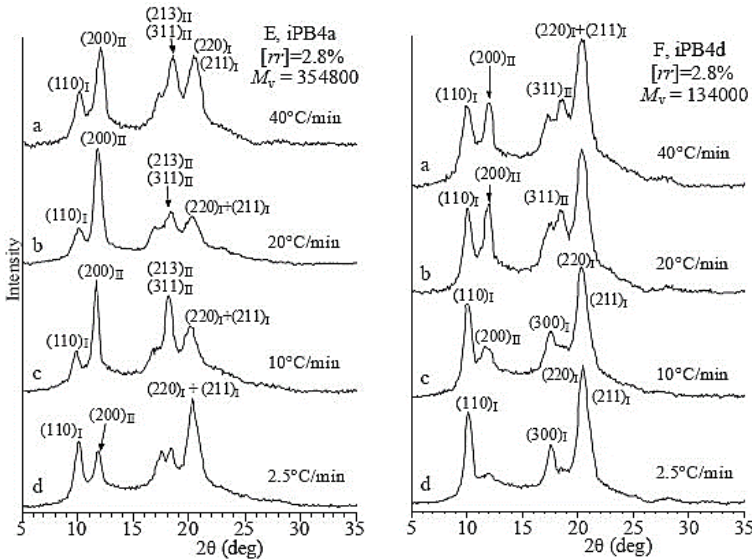
Figure 12. X-ray powder diffraction profiles of samples of iPBu of same stereoregularity but different molecular weight crystallized from the melt by cooling the melt to room temperature (or lower temperature) at the indicated cooling rates. The (110) I , (300) I and (220) I /(211) I reflections of form I at 2θ = 9.9°, 17.3° and 20.5°, and the (200) II , (220) II and (213) II /(311) II reflections of form II at 2θ = 11.9°, 16.9° and 18.3° are indicated. Reproduced with permission from Ref. [80], copyright 2009 American Chemical Society.